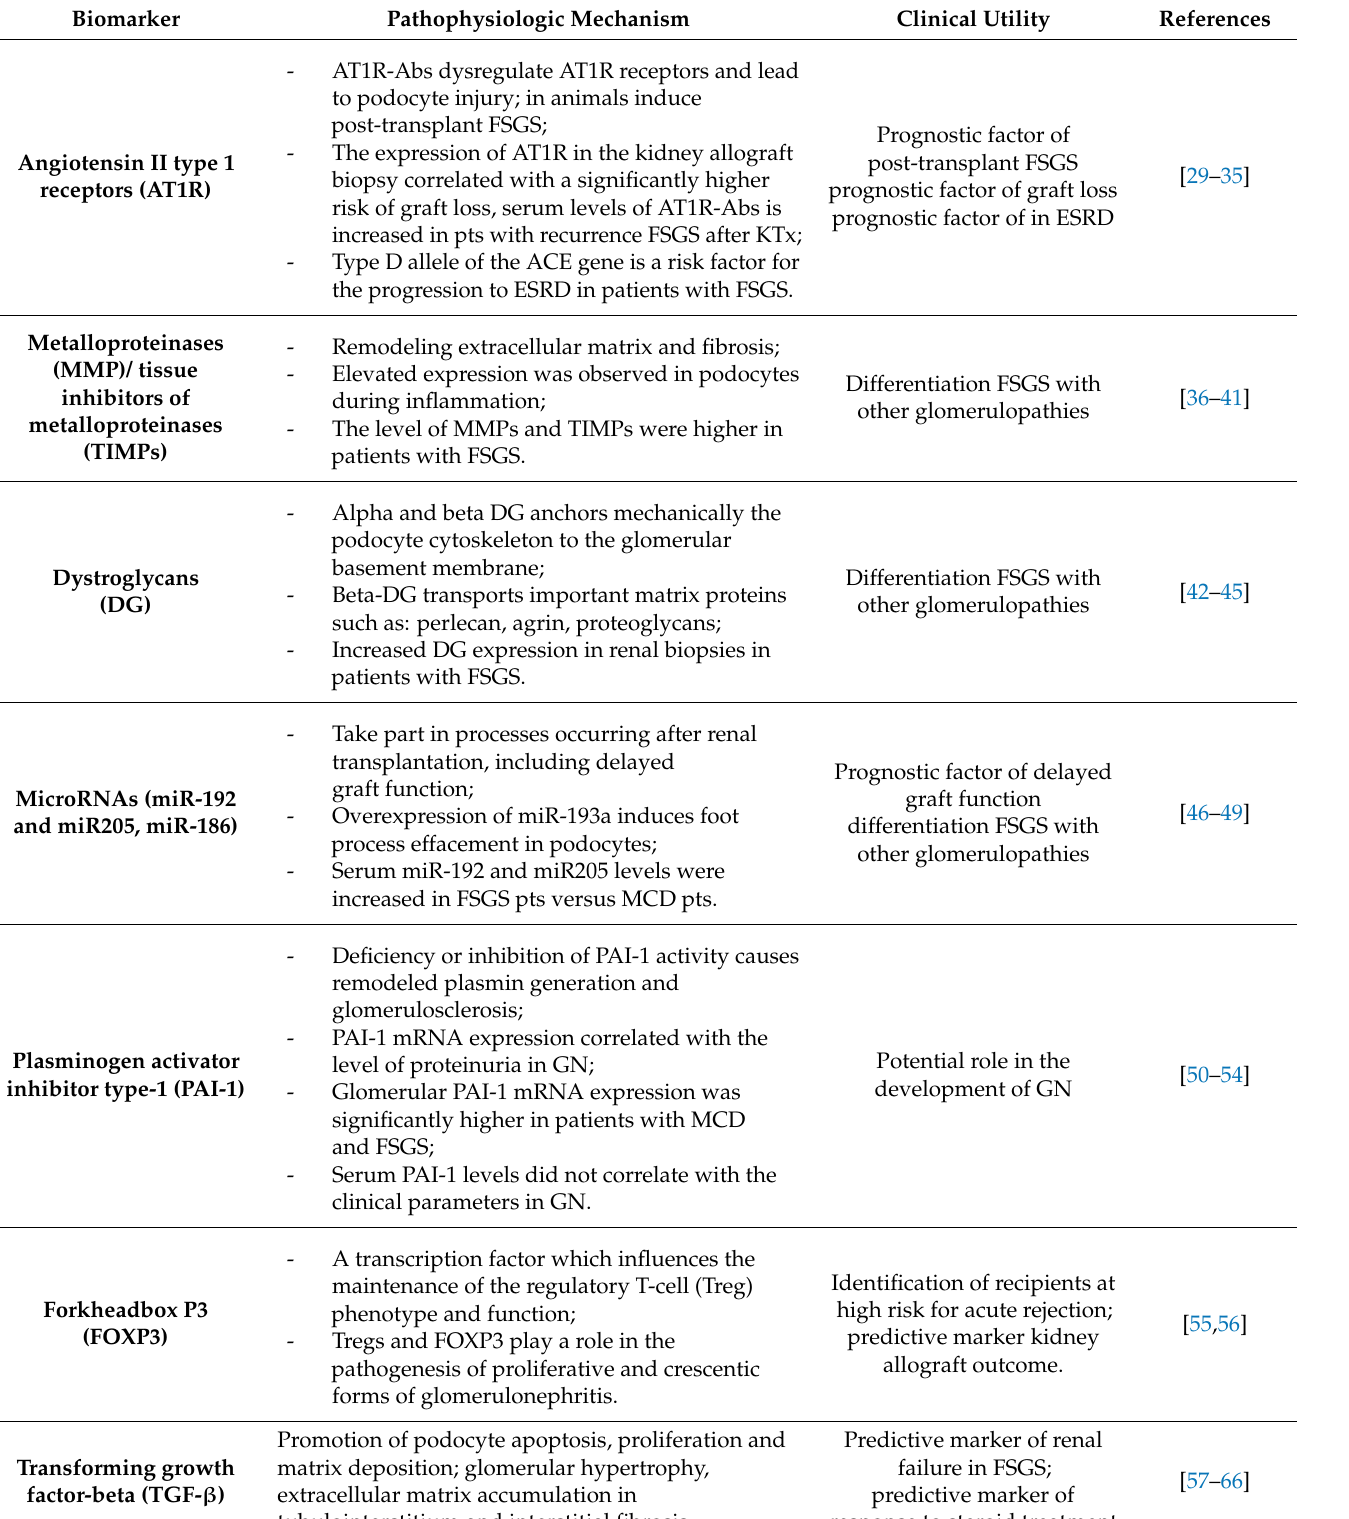
Table 4. Potential biomarkers in